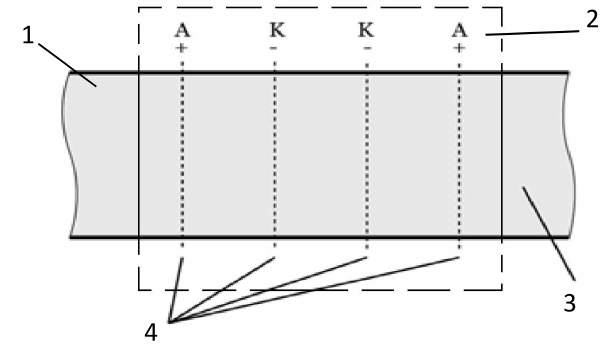
Figure 1. Transforming electrode cell (MET). 1 – channel walls; 2 – electrical package; 3 – electrolyte; 4 – mesh electrodes (external anodes A, internal cathodes K).